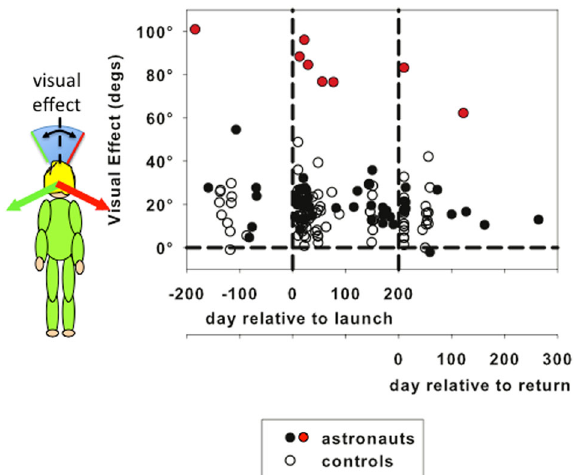
Fig. 3 The visual effect (VE) (shown as the blue shaded area in the insert) plotted as a function of time since launch and of the day relative to return to earth with each observer ’ s data plotted separately. Data from every session performed are plotted for ground controls ( open circles ) and astronauts ( fi lled circles ). One astronaut ( fi lled red circles ) had a substantially larger VE than the others. Details of the time of each data collection session are given Table